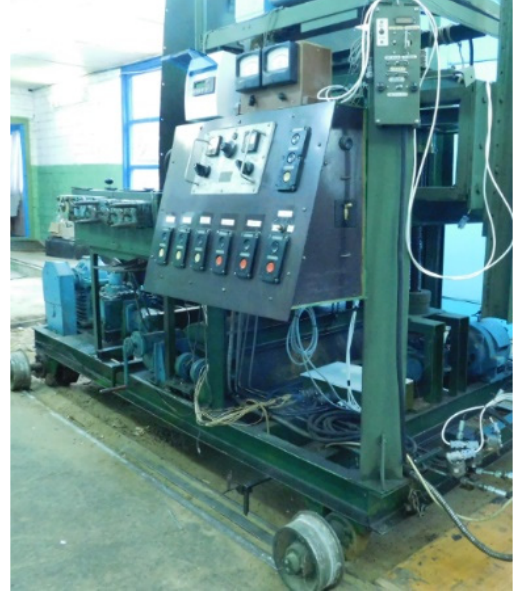
Figure 11. A control panel of the test bench.